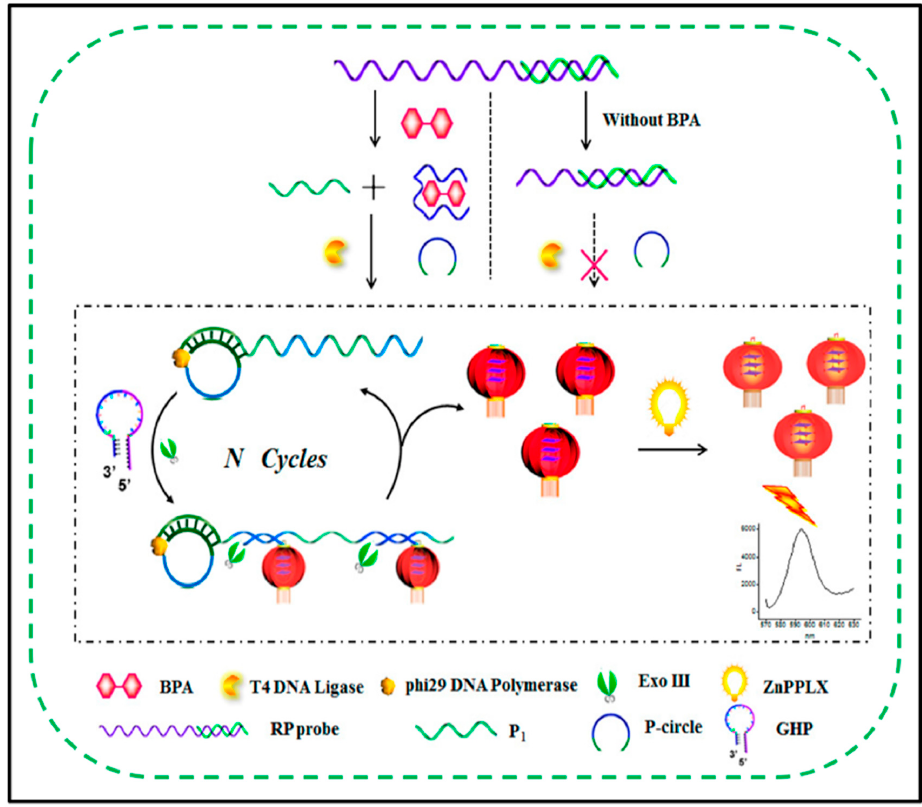
Figure 4. A label-free and sensitive fluorescent qualitative assay for bisphenol A based on RCA/exonuclease III combined cascade amplification. Adapted with permission from ref. [83].